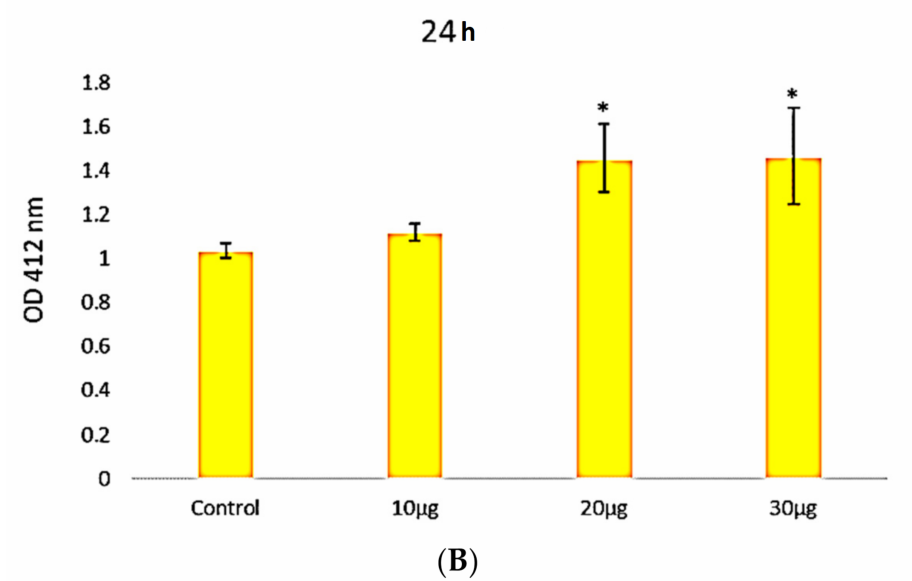
Figure 2. Glucose uptake effect of acetyl-xylogalactan on THK macrophages. ( A ) THK cells treated with acetyl-xylogalactan for 12 h; ( B ) THK cells treated with acetyl-xylogalactan for 24 h. * p < 0.05. All treatment groups were compared to the control group.